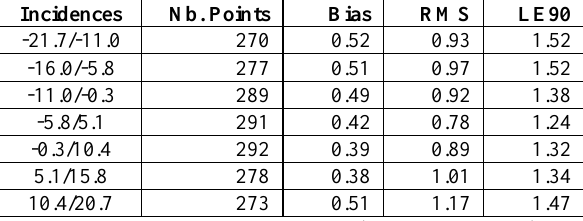
Table 2 Narrow angle stereo pairs (base/height =